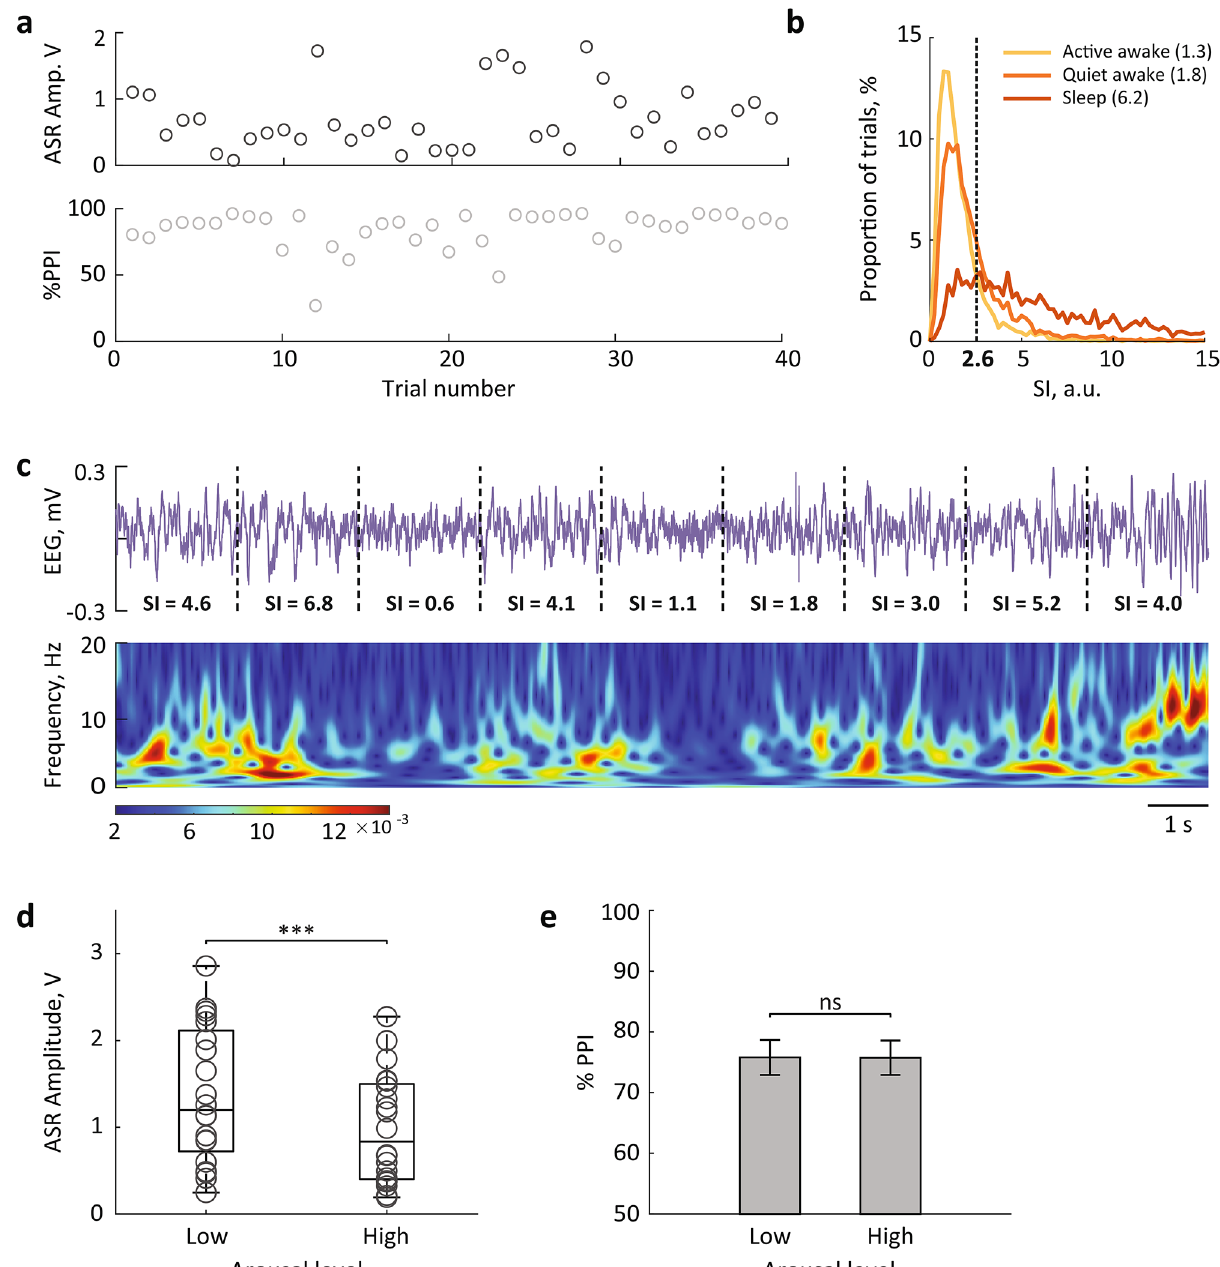
Figure 4. The ASR amplitude varies with arousal. ( a ) Trial-to-trial variability of the ASR amplitude (top) and %PPI (bottom) from a representative session. ( b ) Distribution and medians of SI-values during active awake, quiet awake and sleep states. The threshold for sorting the low and high arousal trials was chosen as the intersection between the SI distributions. ( c ) A representative EEG trace (top) and corresponding spectrogram (bottom) show the moment-to-moment fluctuation of the cortical arousal level; SI-value is indicated for each 2-s interval. ( d , e ) The ASR amplitude ( d ), but not %PPI ( e ) varied with arousal level. ***p < 0.001 (Wilcoxon signed- rank test).